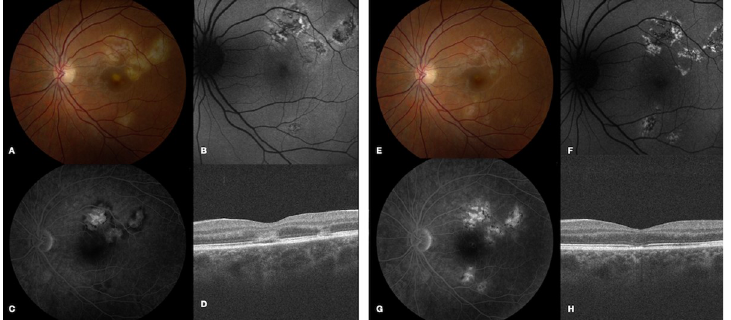
Fig 6. Multimodal imaging during active and inactive disease in patient 1. (A) Fundus photograph in patient 1 during active disease shows fovea-threatening cream-colored placoid lesions. (B) FAF reveals a heterogeneous pattern of central hypoautofluorescent lesions with surrounding stippled hyperautofluorescence. (C) Late stage FA demonstrates late leakage of the placoid lesions without foveal involvement. (D) OCT shows outer retinal architectural disruption. (E) Fundus photography one month later reveals RPE hyperpigmentation and resolution of cream-colored lesions. (F) FAF at this time point demonstrates hypoautofluorescent lesions with surrounding stippled hyperautofluorescence. (G) Late stage FA shows staining with resolved areas of early blockage and late leakage. (H) OCT demonstrates partial restoration of the ellipsoid zone.